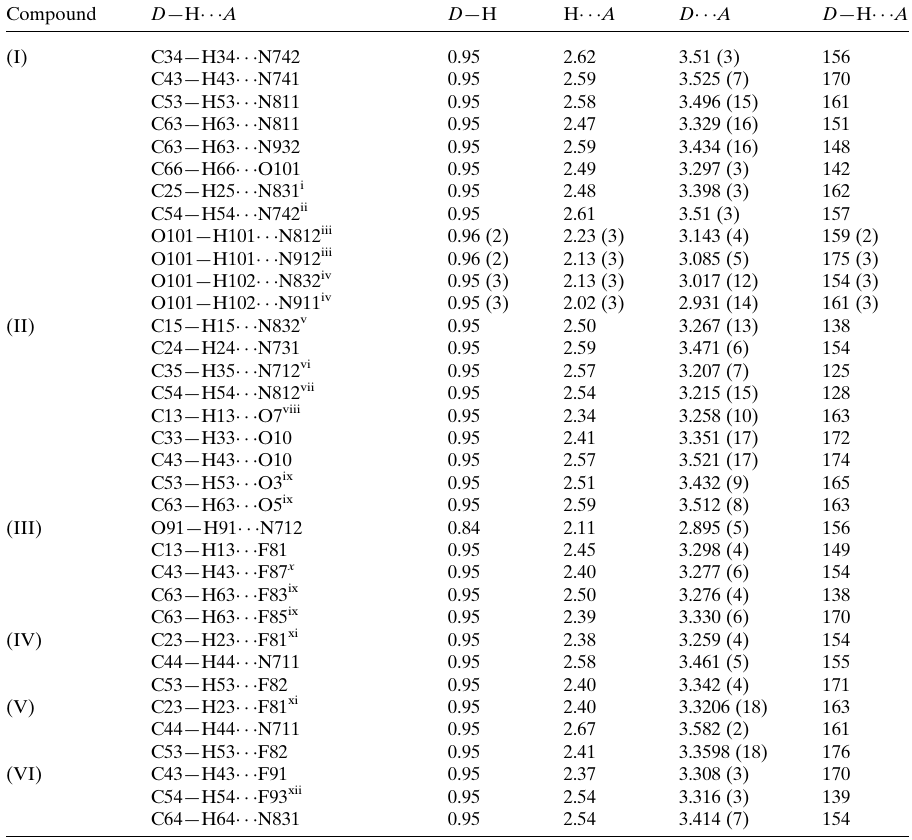
Table 1 Hydrogen bonds and short intra- and intermolecular contacts (A˚ , (cid:5) ). Compound D —H (cid:2)(cid:2)(cid:2) A